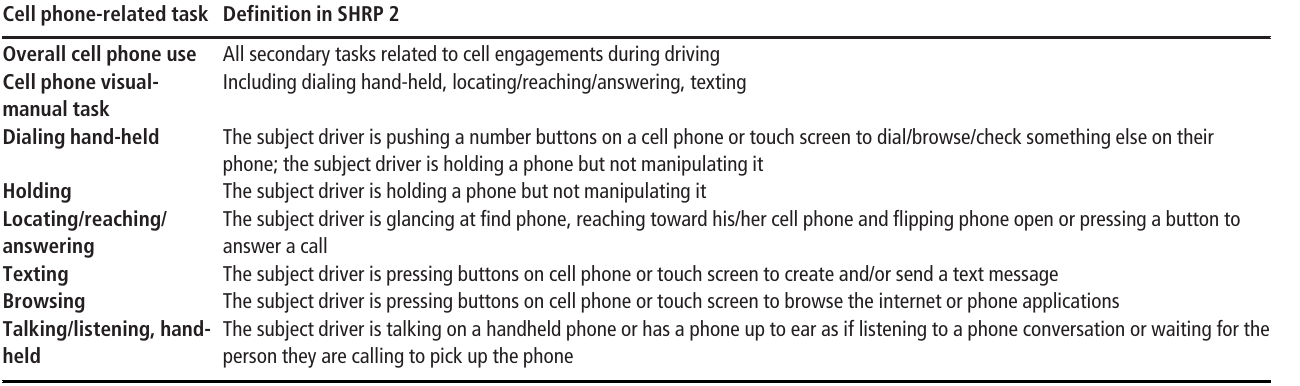
Table II Each speci fi c cell phone task and its de fi nition Cell phone-related task Definition in SHRP 2